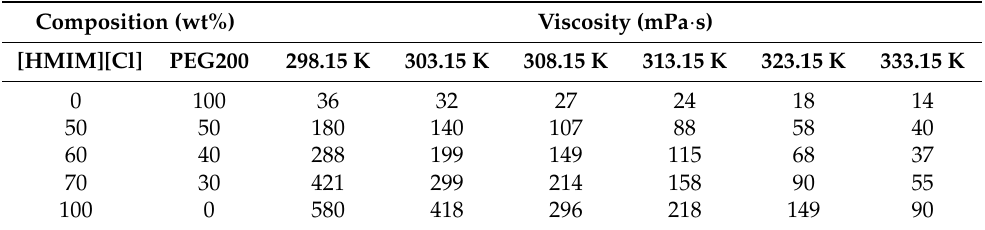
Table 2. Viscosity of complex absorbent with different mass fractions of IL at T = 298.15 to 333.15